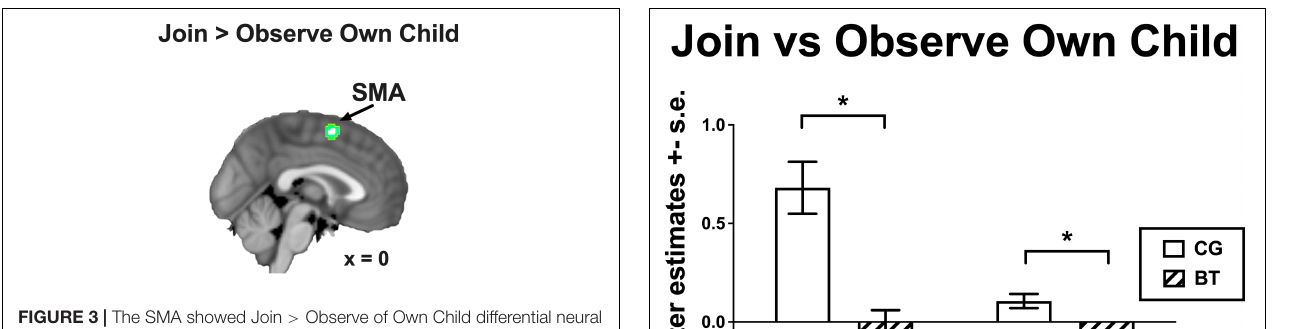
Frontiers in Psychology |